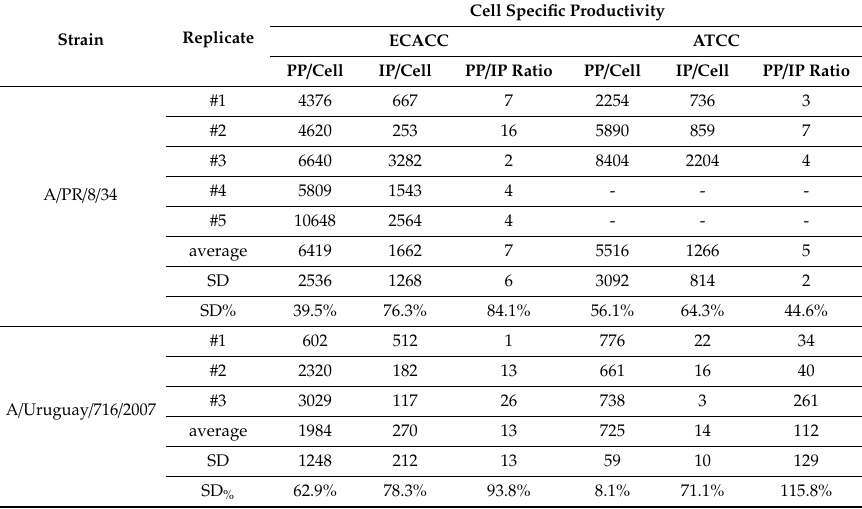
Table A3. Cell specific productivity and PP / IP ratios of influenza virus in suspension cultures with MDCK cells derived from ECACC and